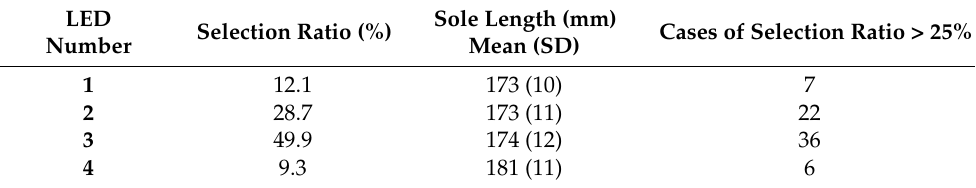
Table 5. Selection ratio for each LED for sole lengths from the heel end to the metatarsal line.